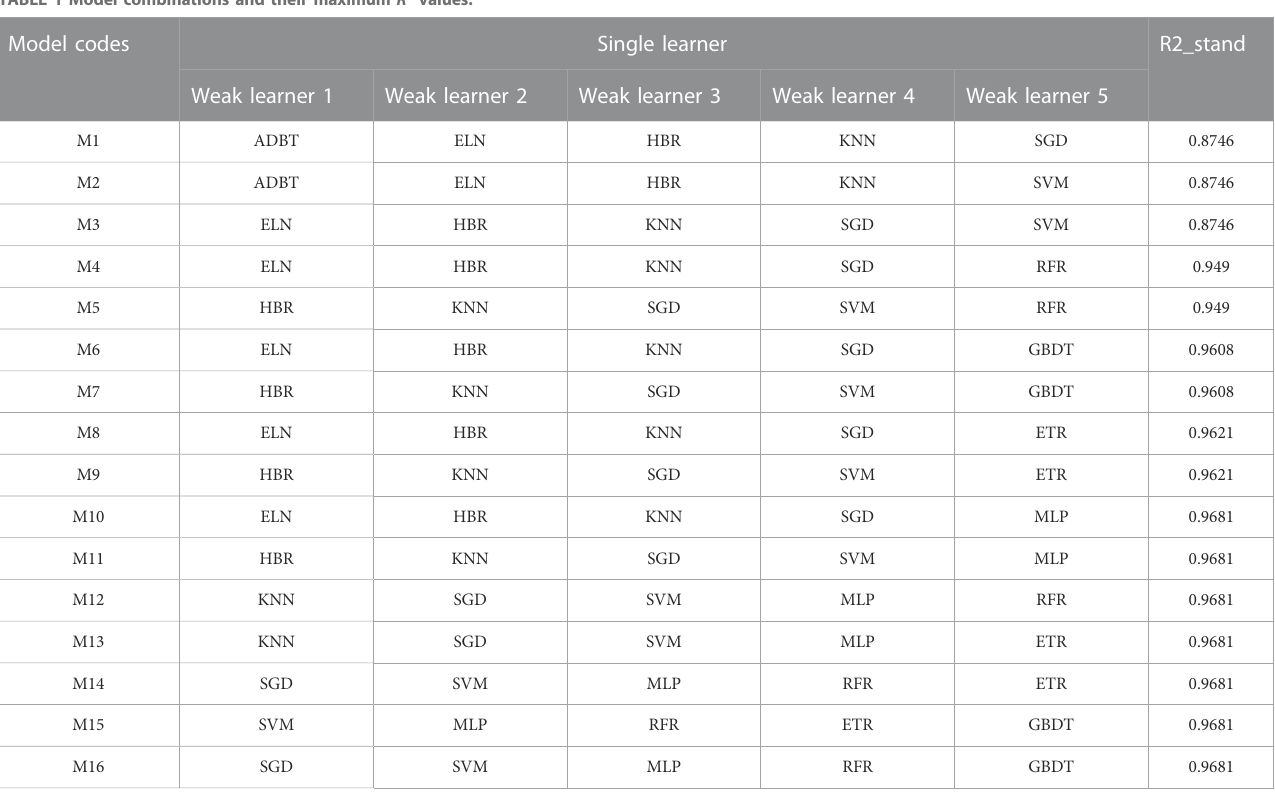
TABLE 1 Model combinations and their maximum R 2